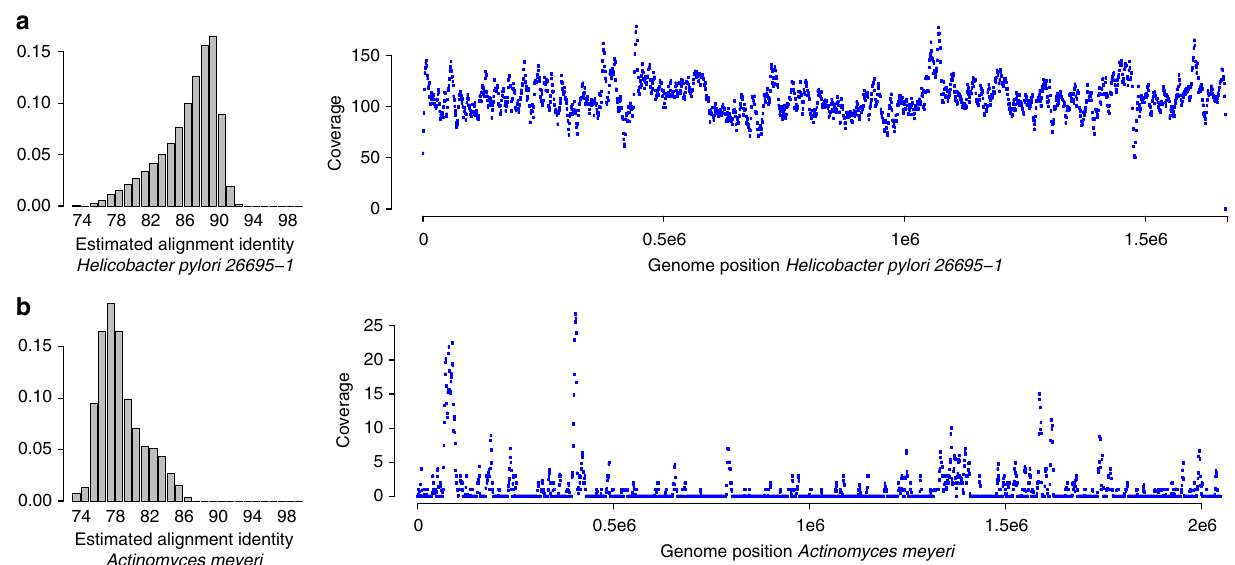
Fig. 6 Alignment identity and spatial genome coverage for in- and out-of-database genomes. The fi gure shows estimated alignment identity and spatial genome coverage for Helicobacter pylori 26695-1 (panel a ) and Actinomyces meyeri (panel b ) in the HMP7 experiment. Actinomyces meyeri is the next-closest database relative for the Actinomyces odontolyticus genome present in the HMP7 sequencing data (mash distance 0.14). Helicobacter pylori 26695-1 is present in HMP7 and in the reference database. Uneven spatial coverage and estimated mapping identities shifted away from the expected mode around 0.88 for Actinomyces meyeri are indicative of a mismatch between the sequencing sample and the reference database. Complete plots for HMP7